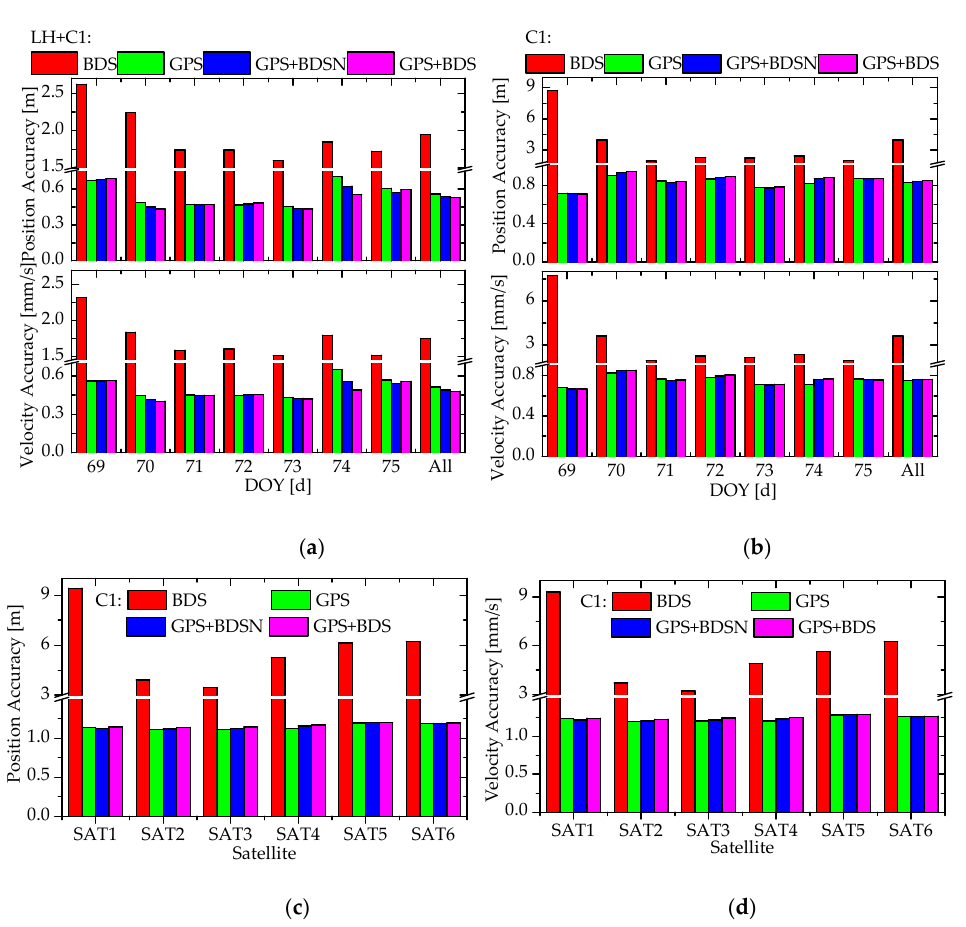
Figure 11. Comparison of real-time orbit accuracies of the FY3C and YG30/SAT1 − SAT6 satellites for four types of GPS/BDS combinations: ( a ) The position and velocity accuracy of the FY3C satellite for the carrier-phase-based solution; ( b ) The position and velocity accuracy of the FY3C satellite for the pseudo-range-based solution; ( c ) The position accuracy of the YG30/SAT1 − SAT6 satellites for the pseudo-range-based solution; ( d ) The velocity accuracy of the YG30/SAT1 − SAT6 satellites for the pseudo-range-based solution.